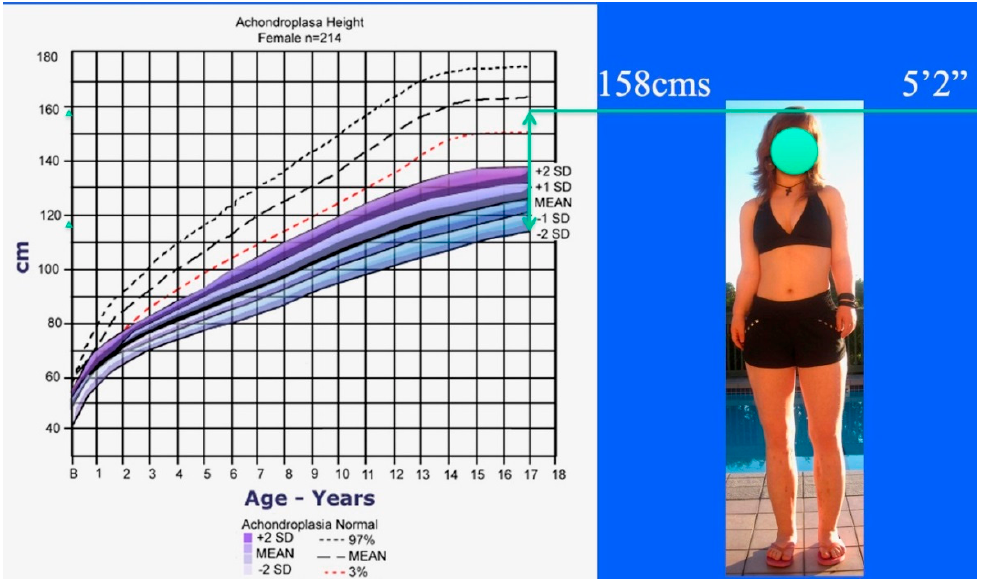
Figure 5. Achondroplastic female height growth chart (lower shaded) compared to normal female height growth chart (upper dashed). Achondroplastic girl from Figure 3 standing to the right of the growth chart showing her 15.75 ″ = 40 cm lengthening added to her preoperative predicted height at maturity (115 cm). Final adult height after three 4-segment leg lengthenings is 5 ′ 2 ″ = 157.5 cm, which is in the normal height range for an adult female.